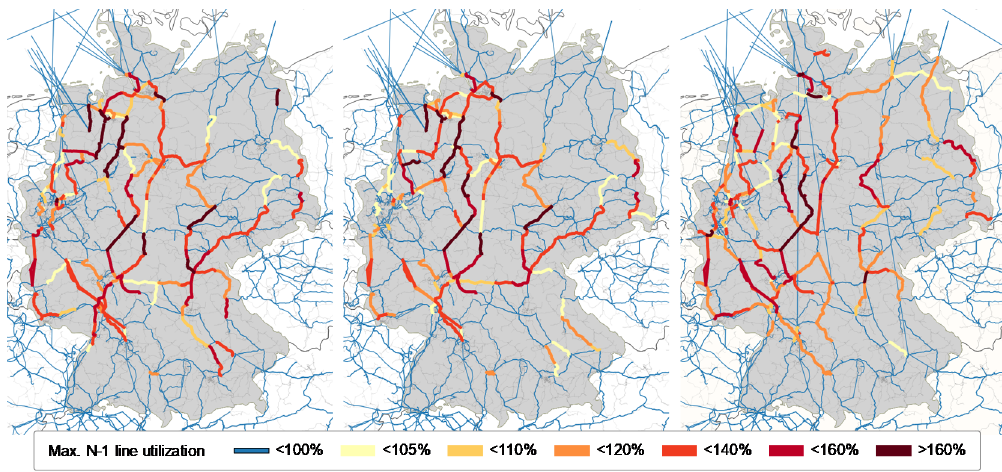
Figure 9. Maximum (N-1)-line utilizations in the German electrical transmission grid for expansion scenario 2023 ( left ), scenario 2023+ ( center ), and scenario 2035 ( right ).